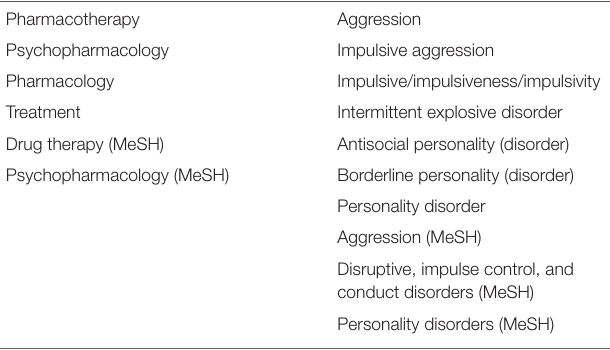
TABLE 1 | List of terms searched for in the initial literature